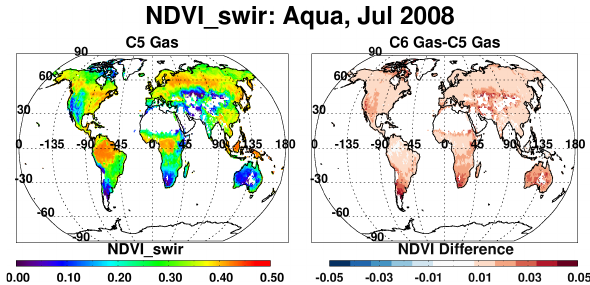
Figure 6: Impact of gas correction assumptions on calculations of NDVI swir . The left panel is the 1°x1° NDVI swir as calculated if using C5 gas correction assumptions, whereas the right panel is the impact of substituting the C6 assumptions (C6-C5).